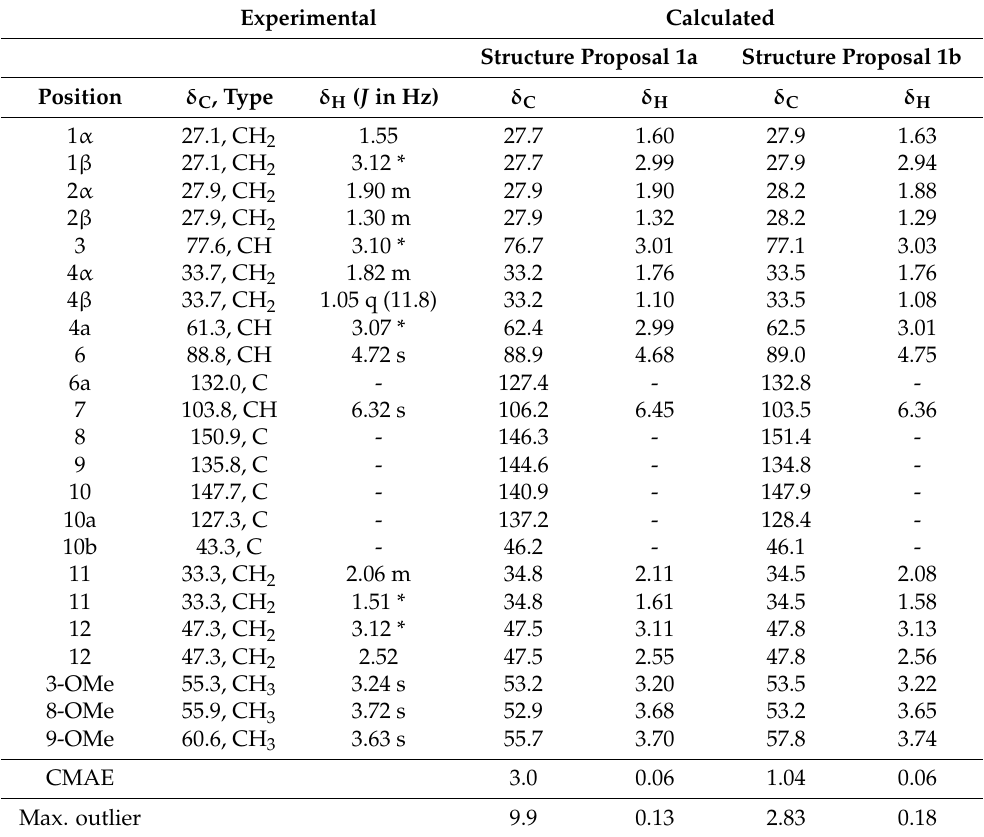
Table 1. Experimental and computed NMR data (400 MHz, (CD 3 ) 2 SO) of compound 1 (major epimer). Experimental Calculated Structure Proposal 1a Structure Proposal 1b